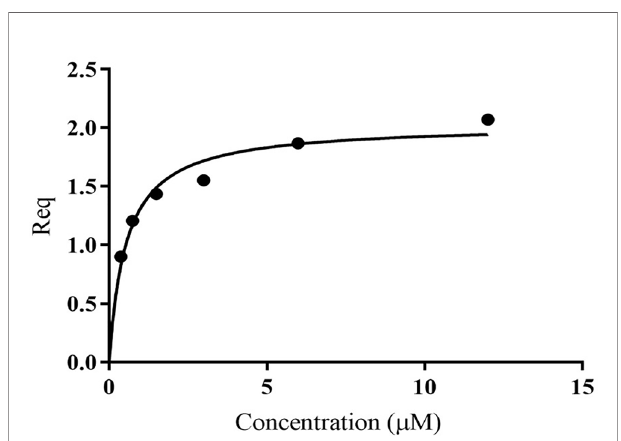
FIGURE 6 | Quanti fi cation of the in vitro binding of Spa33 to MxiN using biolayer interferometry (BLI). MxiN with an N-terminal His 6 -tag was immobilized to sensor tips to measure its ability to bind to wild-type Spa33 heterotrimers. The tips were immersed in different concentrations of Spa33 (lacking a His 6 -tag) to monitor association and dissociation rates (see Supplementary Materials ). The K D was determined based on the equilibrium reaction (Req) at different Spa33 concentrations. The K D value was determined to be 0.55 ± 0.091 µM, which is in agreement with the measured association and dissociation rates. The plotted data were generated using GraphPad